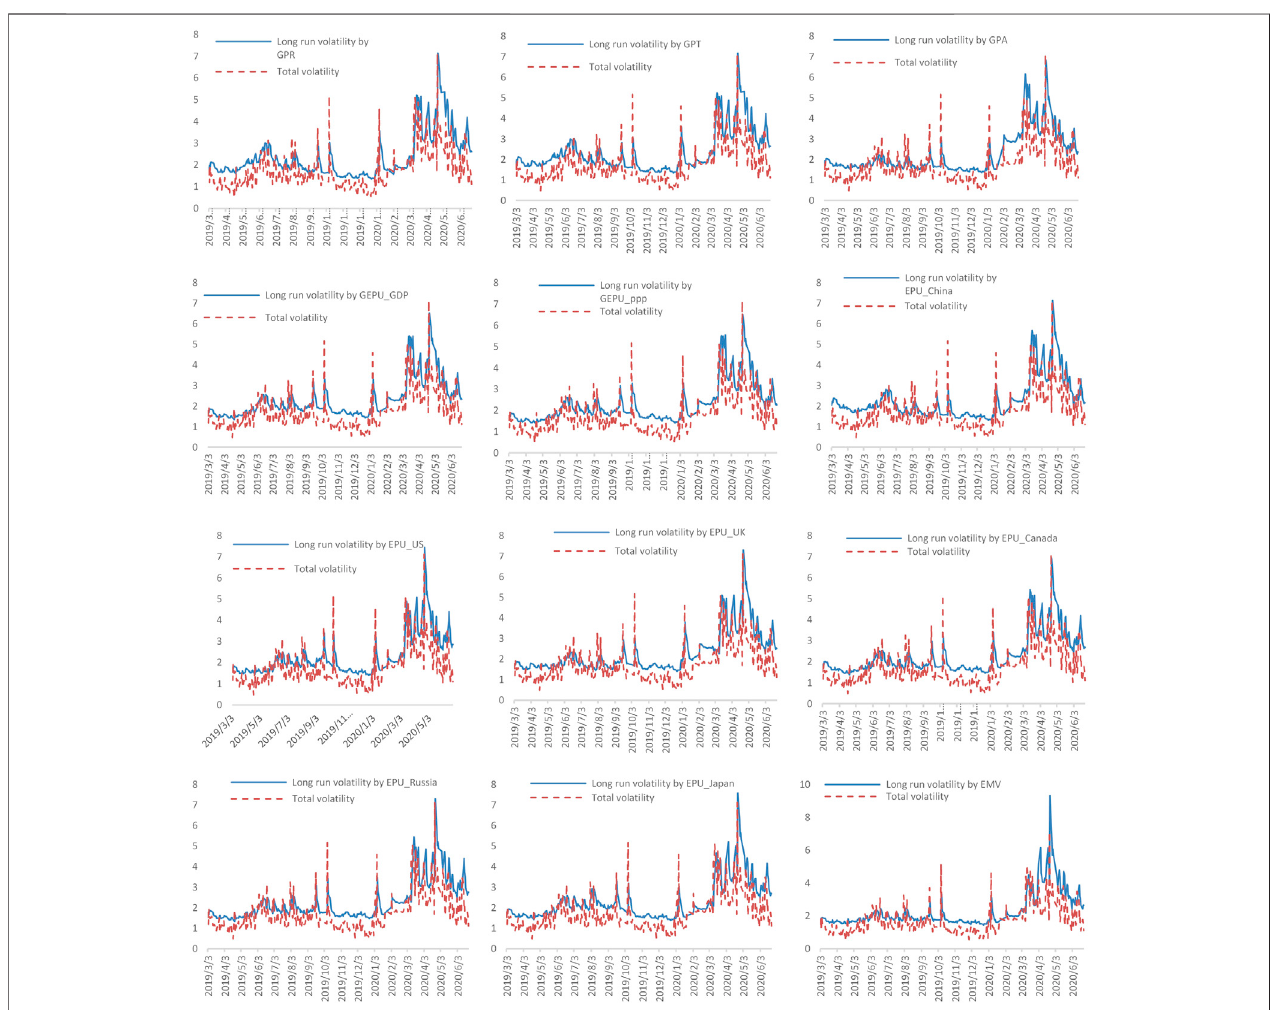
FIGURE 3 | The fi tting value of total volatility and long-term volatility by different GARCH-MIDAS